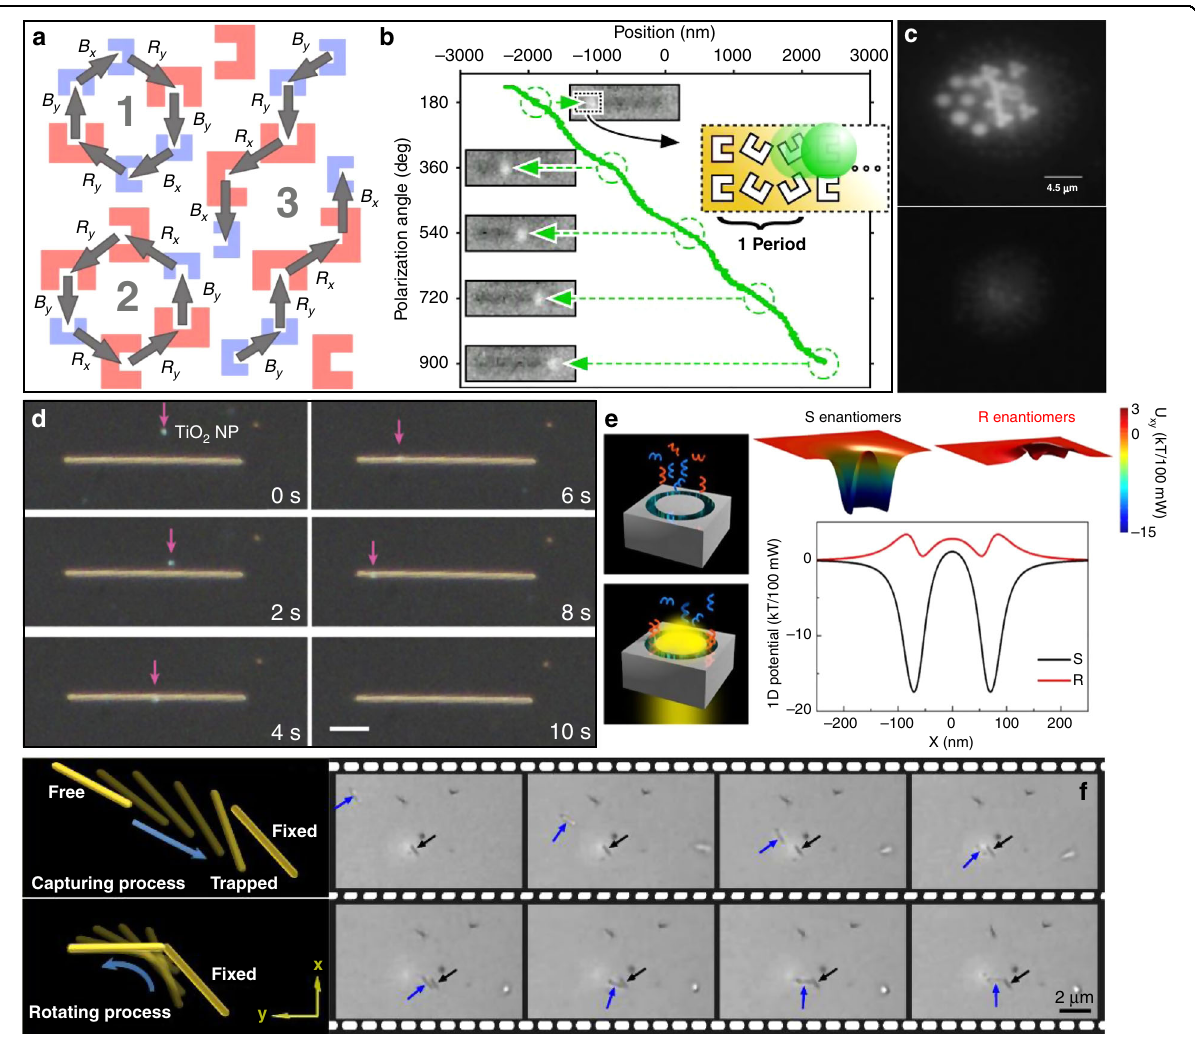
Fig. 17 Plasmonic transport, sorting, and lithography. a Simple transport protocols on a two-dimensional conveyor belt. b Position versus polarization angle for 390-nm beads. c Separation of 1- from 2- μ m particles by an external electric fi eld. Upper: both types of particles were trapped at 10 kHz; lower: expulsion of 2- μ m particles from the trap, leaving only 1- μ m particles remaining captured at 25 kHz. d Transport of a TiO 2 nanoparticle along a silver nanowire. The scale bar is 5 μ m, and the power of the laser was 50 mW. e Enantioselective optical trapping of chiral nanoparticles with plasmonic tweezers. f Building plasmonic structures composed of nanowires on a metal fi lm. a Adapted with permission from ref. 320 , Copyright 2014 American Chemical Society. b Adapted with permission from ref. 319 , copyright 2014 American Chemical Society. c Adapted with permission from ref. 174 , Copyright 2014, American Chemical Society. d Adapted with permission from ref. 78 , Copyright 2016, The Royal